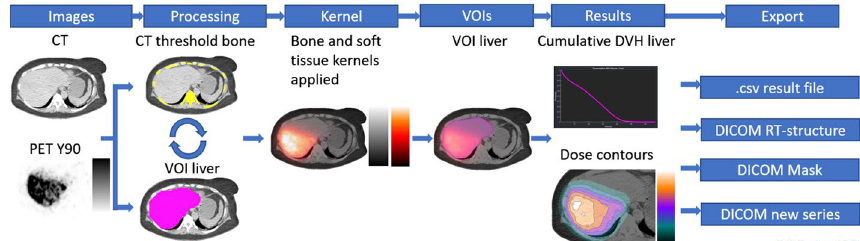
Fig. 15 Y90 dosimetry workflow using computed tomography (CT) and positron emission tomography (PET) images. DVH, dose-volume histogram; VOI, volume of